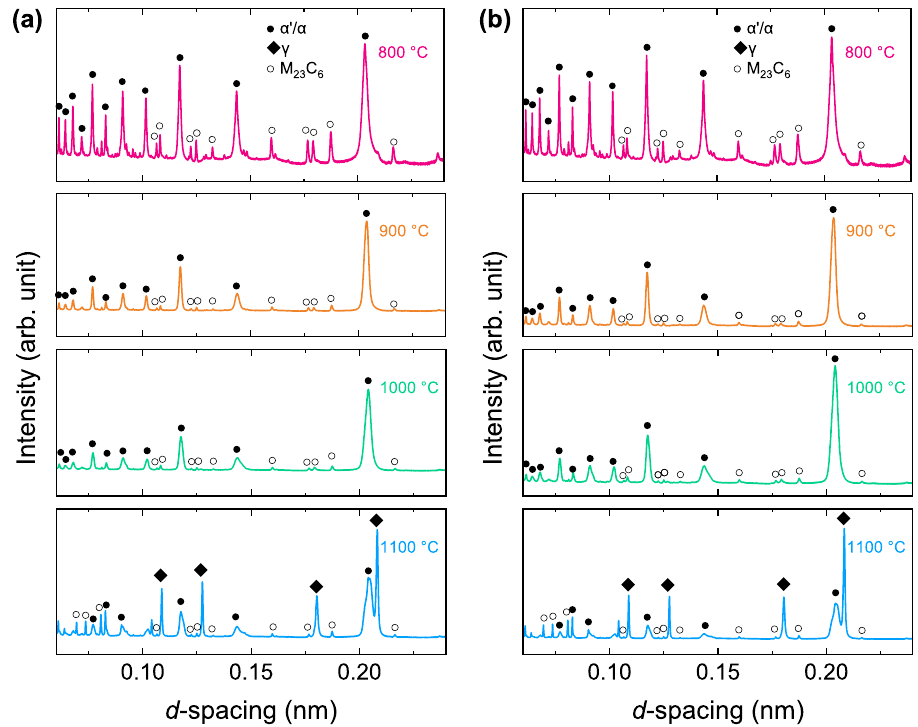
Fig. 3 Phase distributions of the developed steels obtained at different heat treatment temperatures. Neutron diffractograms of the a 13Cr and b 16Cr steels heat treated at different temperatures. Intensity is displayed on the logarithmic